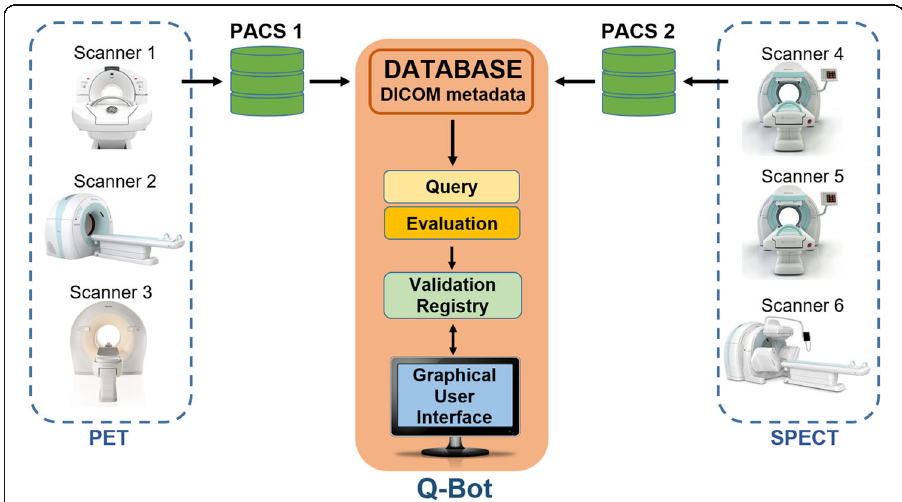
Fig. 2 Data flow from the image data acquired on the scanners to the Q-Bot software tool. The Q-Bot consists of five main components: the DICOM tag database, the query module, the evaluation module,